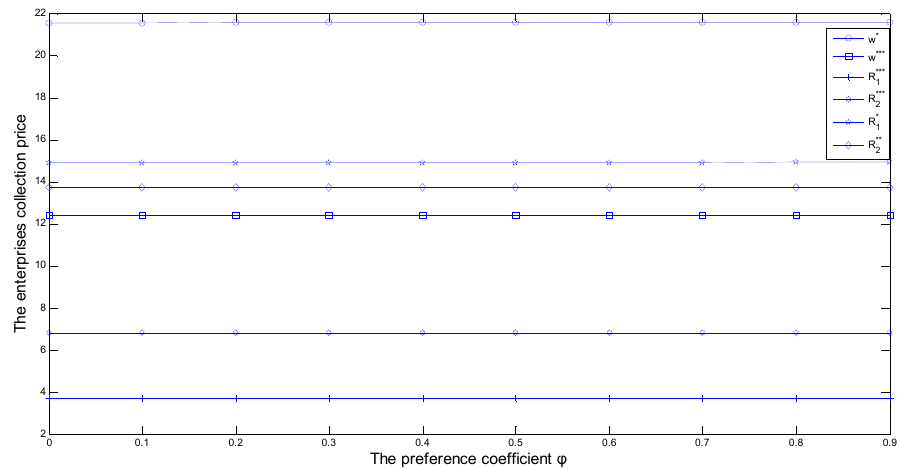
ϕ ϕ on the collection price on the collection price